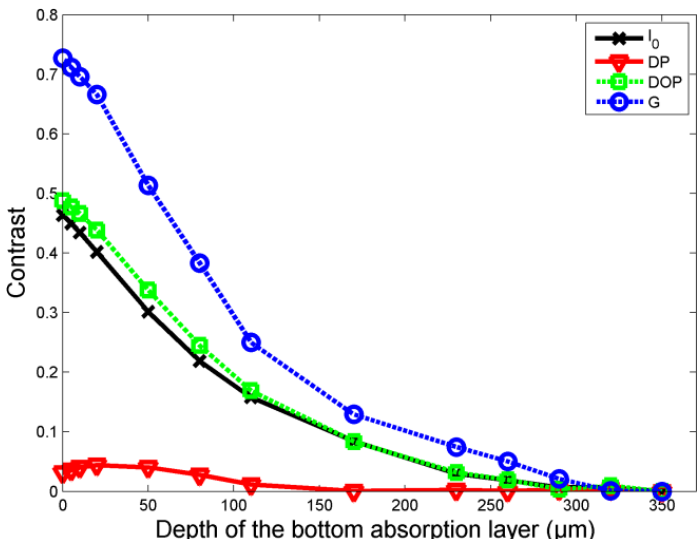
Fig. 6. Monte Carlo simulated relative contrasts of four imaging parameters: intensity, DP, DOP, RLPI parameter G , at di®erent depths of the bottom absorption layer for a two-layer structure with top isotropic layer and bottom anisotropic layer. The absorption coe±cient of the bottom layer is 20 cm (cid:1) 1 . The depth of the bottom layer varies from 0 to 350 (cid:3)